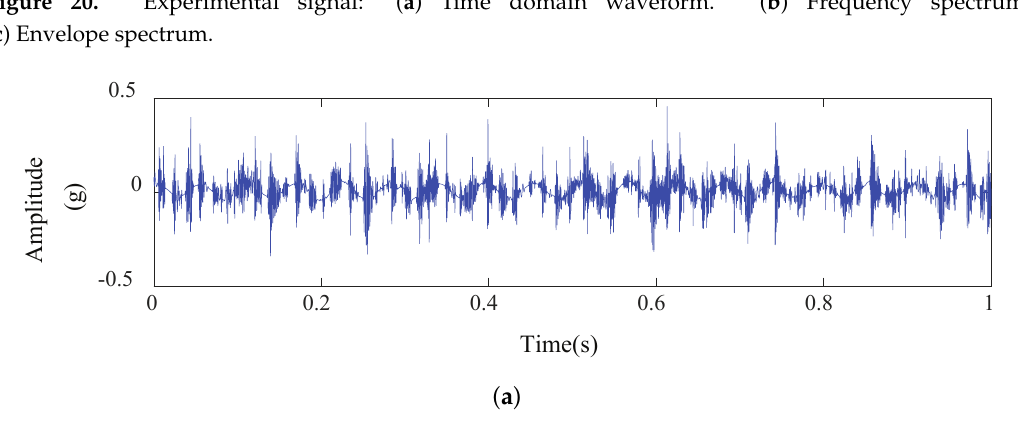
Figure 20. Experimental signal: ( a ) Time domain waveform. ( b ) Frequency spectrum. ( c ) Envelope